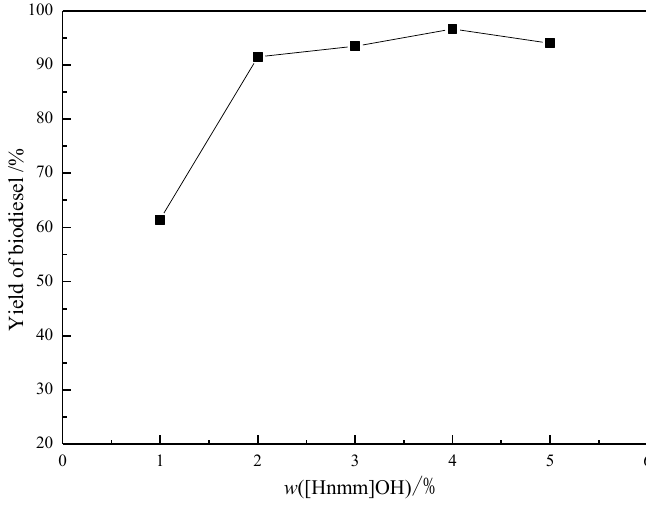
Figure 3. Effect of [Hnmm]OH concentration on yield of biodiesel Reaction conditions: n (Methanol)/ n (Oil) = 8; T = 70 °C; t = 2 h.